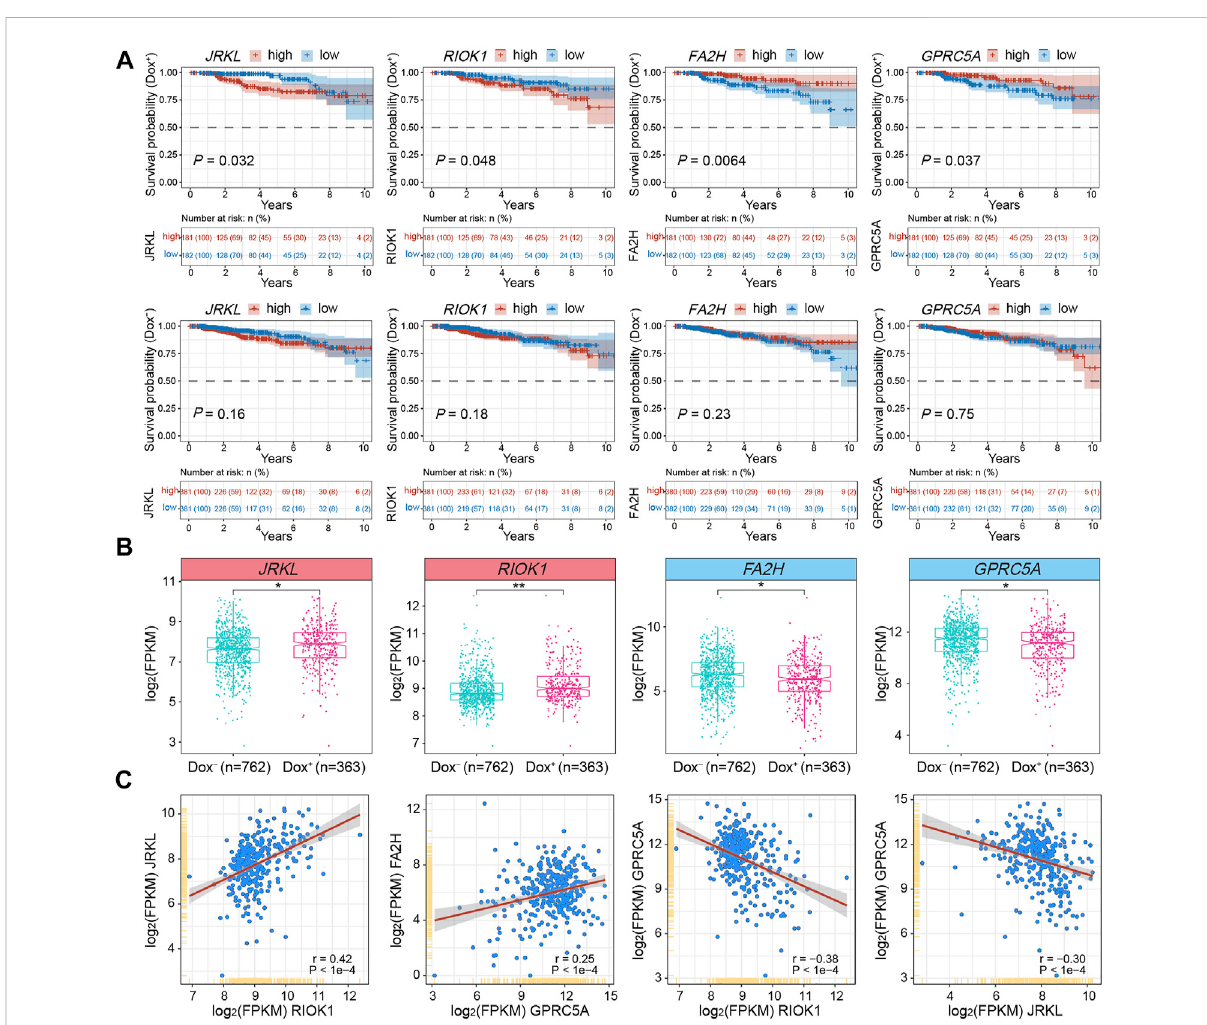
FIGURE 6 Integrative analysis of DEGs associated with changed EPIs using TCGA-BRCA clinical data and subtypes. (A) Kaplan-Meier survival analyses for JRKL , RIOK1 , FA2H and GPRC5A of BRCA patients treated with (Dox + ; top panel; n = 363) and without (Dox − ; bottom panel; n = 762) doxorubicin (adriamycin). Expression values (FPKM) were sorted according to high and low expression from the median of the corresponding genes. The shaded areaindicatesthe95%con fi denceinterval.Statisticalanalysiswasperformedbythelog-ranktest,and p < 0.05wasstatisticallysigni fi cant.Allthe survival duration wascensored to 10 years (B) Box plots showing the mRNA expression levels(FPKM) of JRKL , RIOK1 , FA2H and GPRC5A inDox + and Dox − breastcancersubgroupsderivedfromTCGAdatasets.The p valueswerecalculatedbyWilcoxon ’ ssigned-ranktestintheRplatform.* p < 0.05, ** p < 0.01. (C) Correlation analysis of mRNA expression levels (FPKM) among JRKL , RIOK1 , FA2H and GPRC5A in the Dox + breast cancer subgroup. The Pearson ’ s correlation coef fi cients (r) and p values were calculated using the “ corrplot ” package in R. The p values < 0.05 were considered to be statistically signi fi